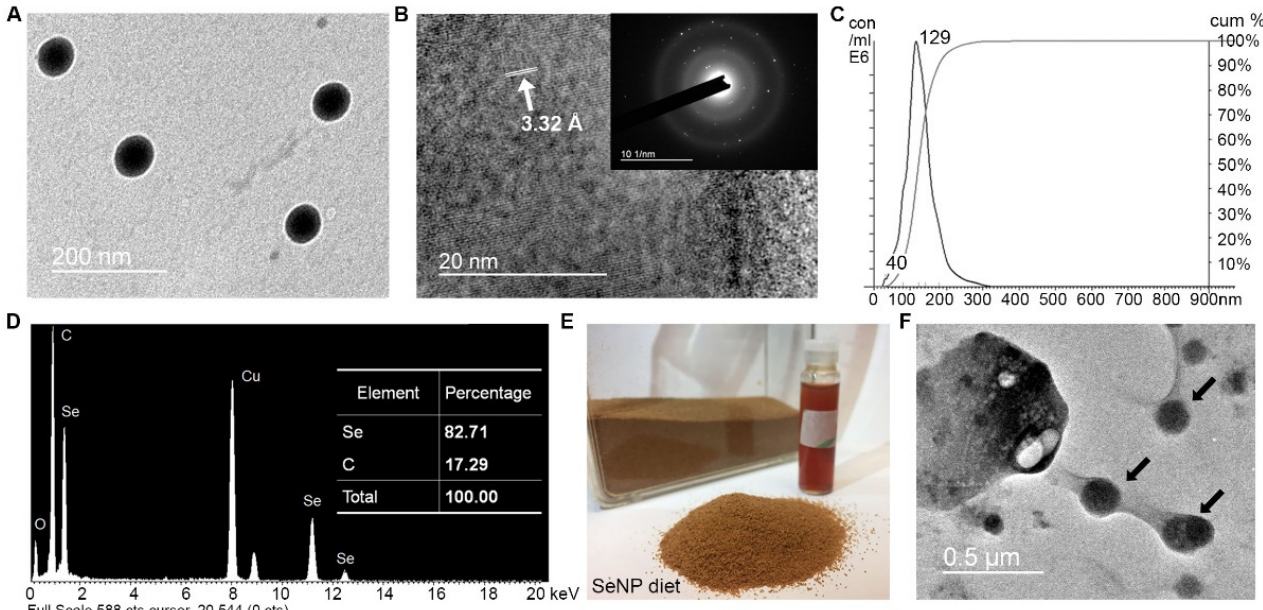
Figure 1. Characterization of chitosan-stabilized SeNPs and the diet: ( A ) representative TEM image of SeNPs; ( B ) representative HR-TEM image of SeNPs (Inset: SAEN pattern of SeNPs); ( C ) size distribution of SeNPs by NanoSight (Mean: 129 nm, SD: 40 nm); ( D ) Elemental analysis by EDX spectrum; ( E ) representative image of SeNP diet; ( F ) representative TEM image of SeNP diet (black arrows indicated SeNPs attaching on fish diet